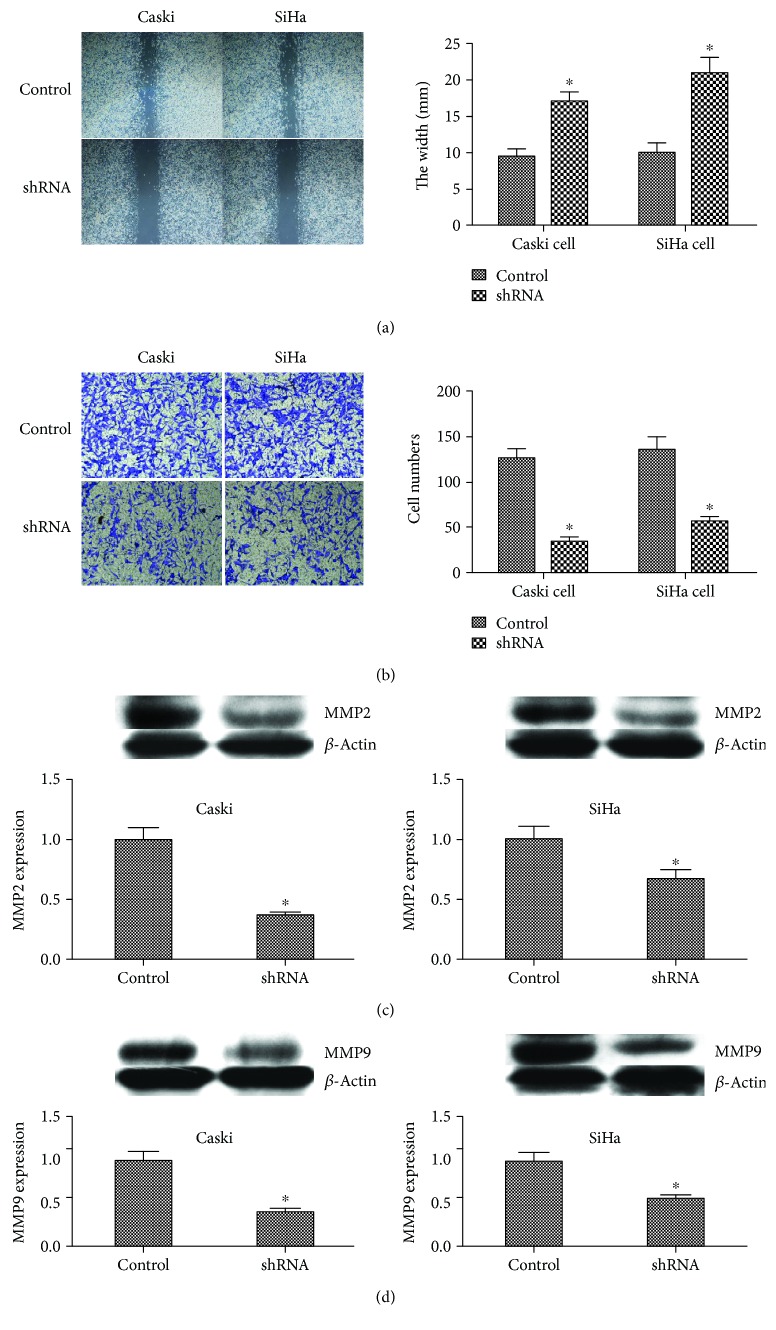
The role of PTK7 in cell migration and invasion in cervical cancer. (a) Cell scratch assay. The PTK7 knockdown group showed to have a great scratch gap in both two cervical cancer cell lines than control groups, respectively (∗P < 0.05). (b) Cell invasion assay. The number of invasive cells in PTK7 knockdown groups was significantly lower than the control groups (∗P < 0.05). (c, d) Western blot assay showed that MMP2 and MMP9 proteins were significantly downregulated in the PTK7 knockdown group compared to the control (∗P < 0.05).